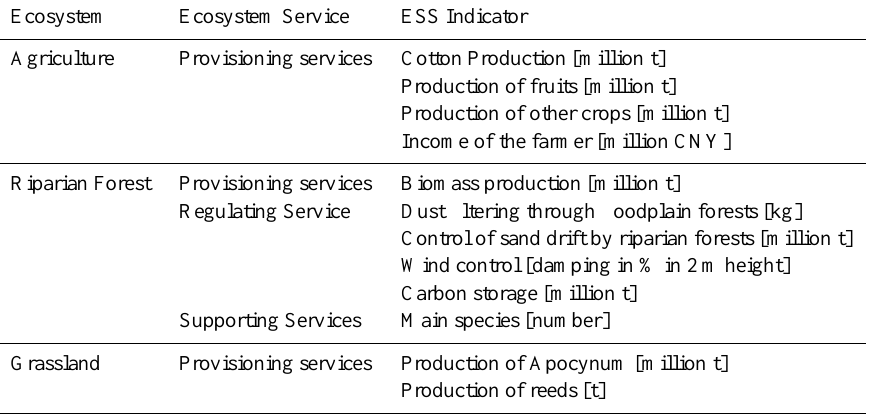
Table 3. Socio-economic indicators in the DSS.